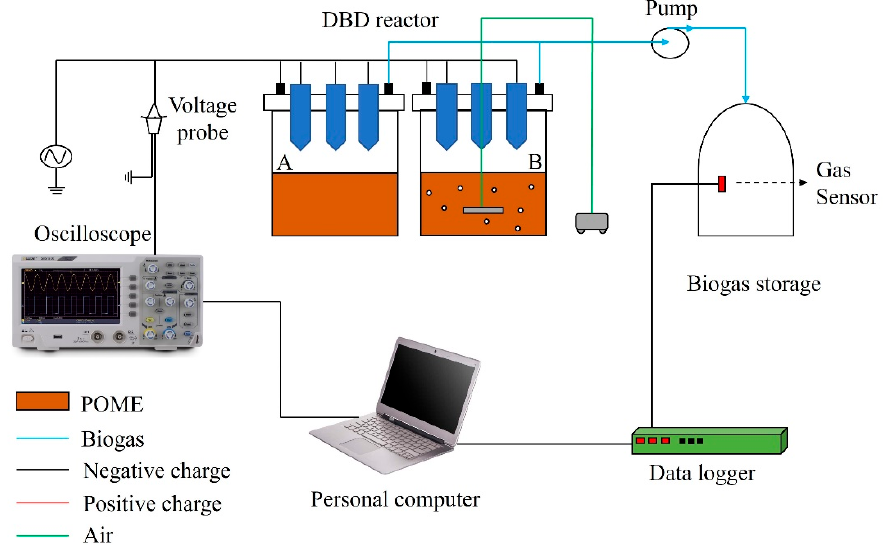
Figure 1. Schematic diagram of the DBD treatment systems. A is the non-aerated condition and B is the aerated condition. Each reactor was supplied with discharge voltages of 15, 20, and 25 kV.